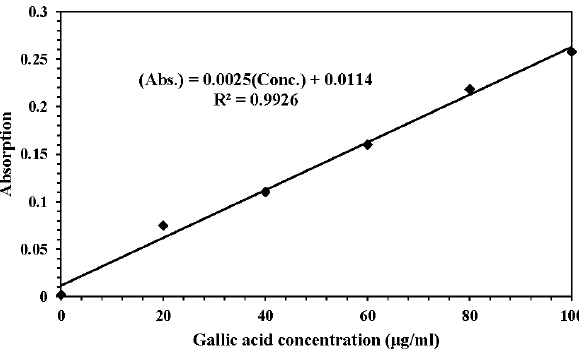
Figure 4: Standard graph for Folin-Ciocalteu method. (Abs.) refers to “Absorption” and (Conc.) is “Gallic acid concentration”.